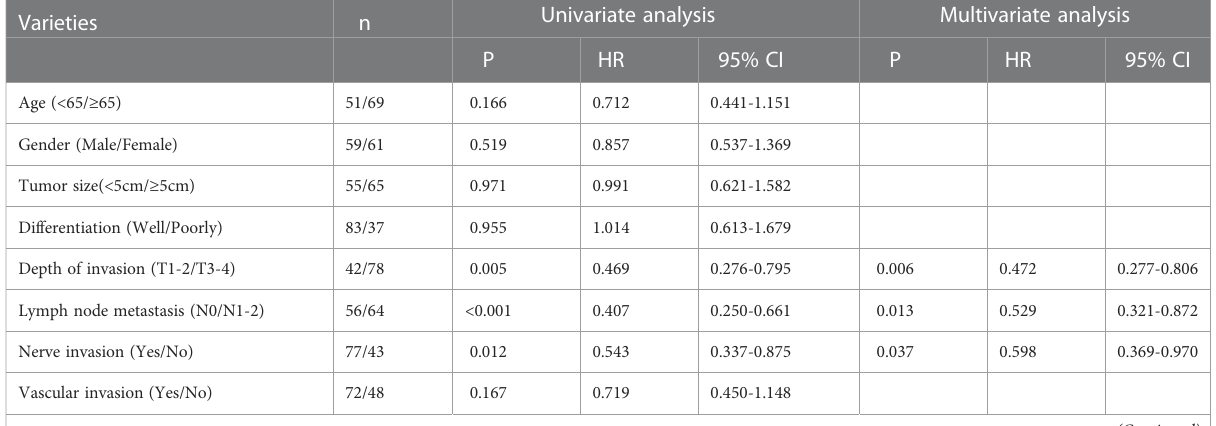
TABLE 2 Results of univariate and multivariate analyses of postoperative patients ’ survival by Cox ’ s proportional hazard model. Varieties n Univariate